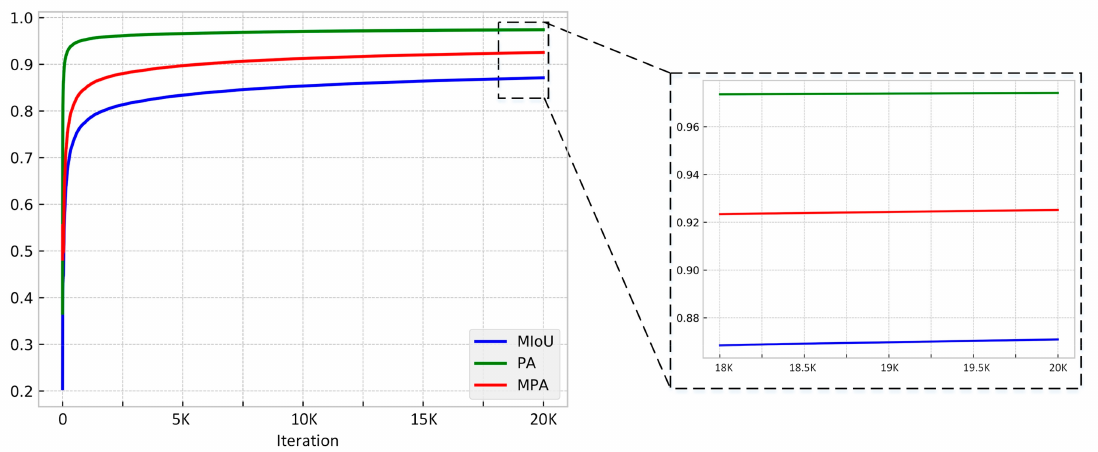
Figure 7. The MIoU, PA and MPA of the proposed EMA-DenseNet on the public crack dataset during each iteration, the figure on the right is a magnification of the interval on the